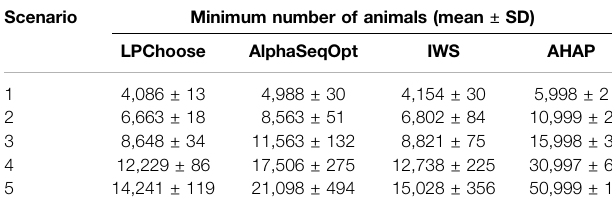
TABLE2| Minimumnumberofanimalsidenti fi edrepresentingallhaplotypesinthe population.